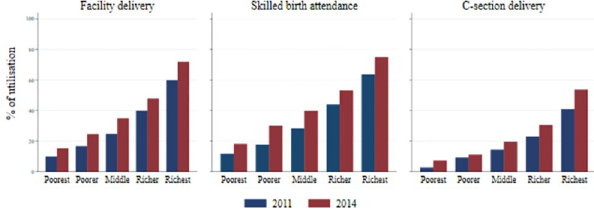
Fig 1. Proportion of delivery care service utilisation by wealth quintiles.